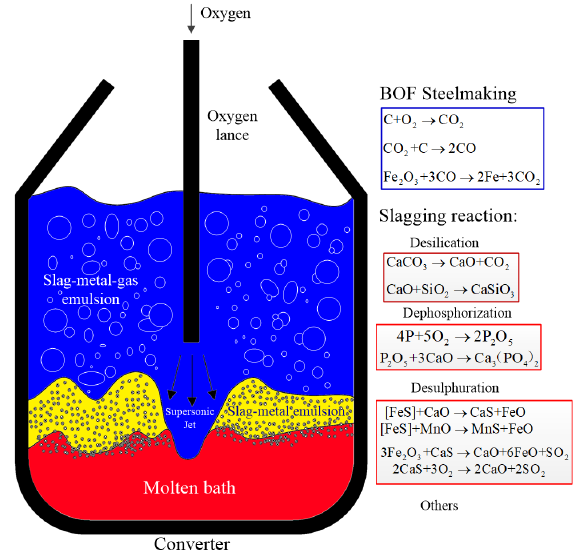
Figure 1. Basic oxygen furnace steelmaking and slagging